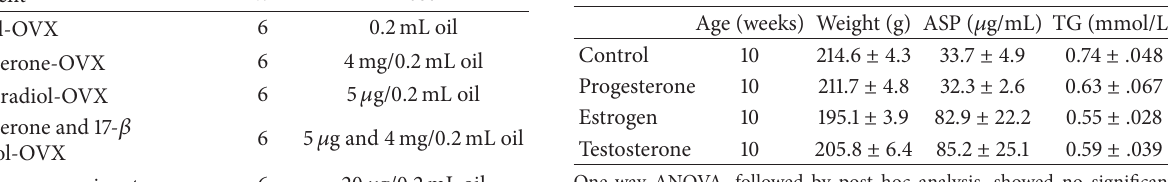
Table 1: Hormones concentrations delivered in 0.2 mL sesame oil. Table 2: Mean weight and age of rats ( 𝑛 = 6 ) and basal ASP ( 𝜇 g/mL) and TG (mmol ⋅ mL) levels after hormone